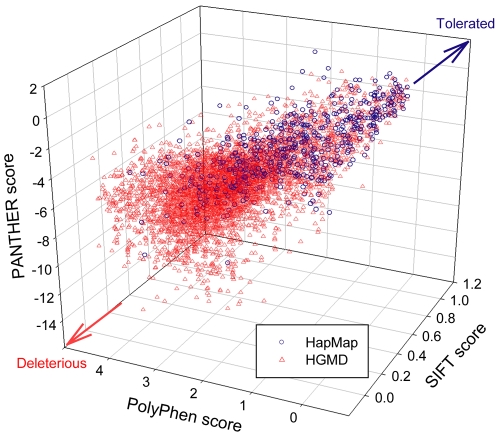
Scatter plot of predicted scores of SIFT, PolyPhen, and PANTHER.Red triangles and blue circle plots indicate missense mutations and nsSNPs, respectively. The ranges of predicted scores of the three programs were different from each other (0–1 for SIFT, 0–4.6 for PolyPhen, and -13.4–1.1 for PANTHER). Lower SIFT or PANTHER scores, or higher PolyPhen scores indicate that the predicted variant is more deleterious. A close distribution in the left lower corner represents an agreement of the three programs on deleterious effect.